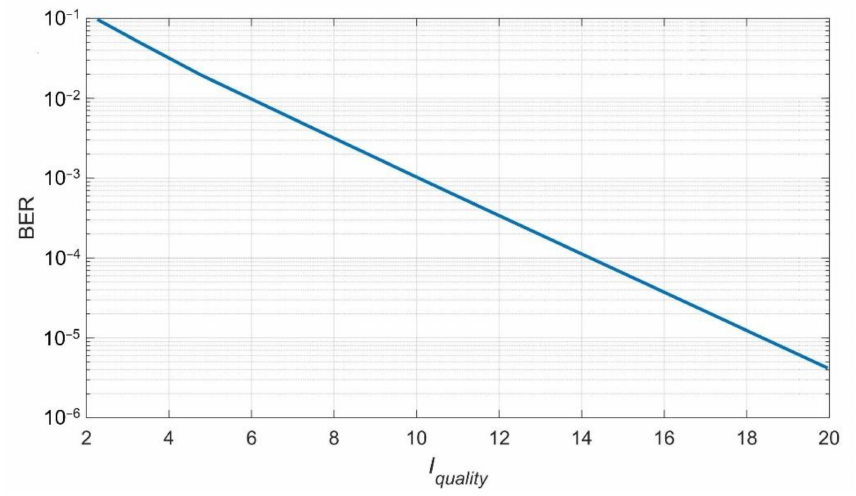
Figure 3. The relation between the BER and the I quality